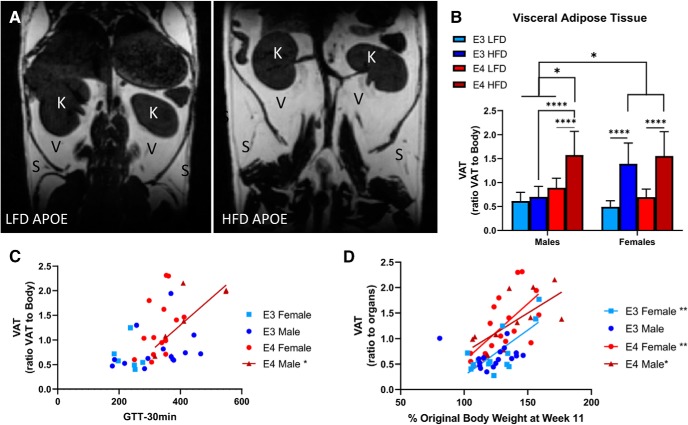
HFD increases VAT in APOE3 and APOE4 mice. Representative image of VAT and SAT in LFD mouse and HFD mouse. S, SAT; V, VAT; K, kidneys (A). Within sex and across sex quantification of VAT in APOE3 and APOE4 mice (B). Correlation of glucose intolerance and VAT accumulation across APOE genotypes and across sex. Lines indicate significant correlations (C). Correlation of weight gain and VAT accumulation across APOE genotypes and across sex. Lines indicate significant correlations (D). B, N = 5–9. Within sex comparison: ****p < 0.0001, three-way ANOVA Tukey’s multiple comparison test. Across sex comparison: *p < 0.02, three-way ANOVA Tukey’s multiple comparison test. C, D, Linear regression analyses. C, APOE3 female (N = 6): R
2 = 0.52, p = 0.005; APOE4 male (N = 7): R
2 = 0.48, p = 0.01; APOE4 female (N = 14): R
2 = 0.43, p = 0.003. D, APOE4 male (N = 14): R
2 = 0.62, p = 0.03.